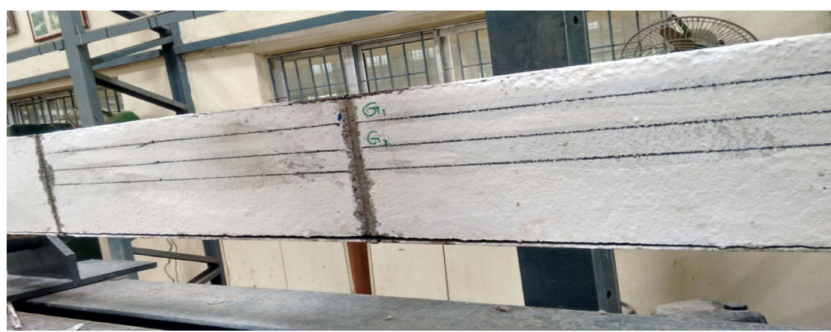
Figure 9. Compression and tension plate debonded.